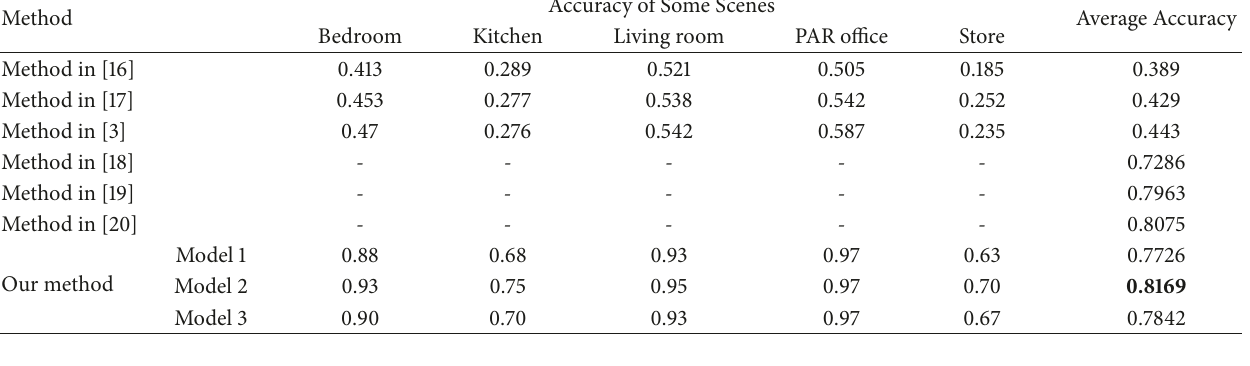
Table 7: Comparison between the proposed method and other advanced methods on MIT 67 dataset. Method